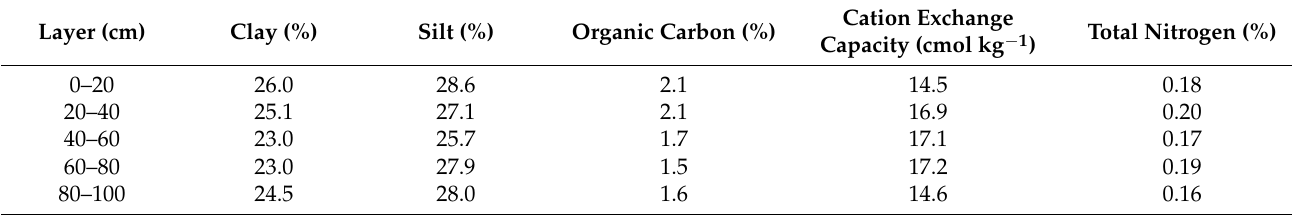
Table 4. Soil properties of five soil layers at the experiment